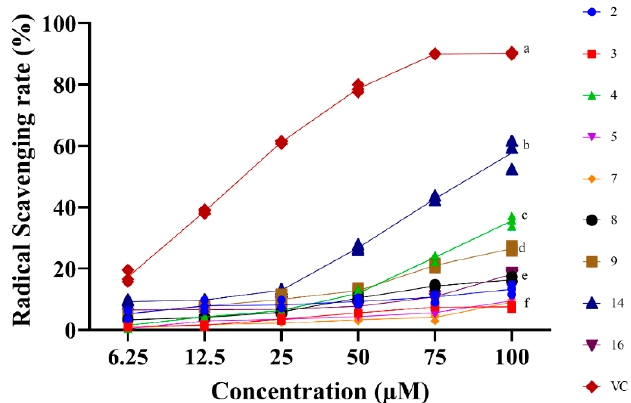
Figure 6. Free radical scavenging rates of isolated compounds from S. doederleinii by DPPH assay. The positive control used was Vitamin C (VC). Letters (a–f) indicate that the values are significantly different at a level of p < 0.05 ( n = 3) by one-way ANOVA DMRT.